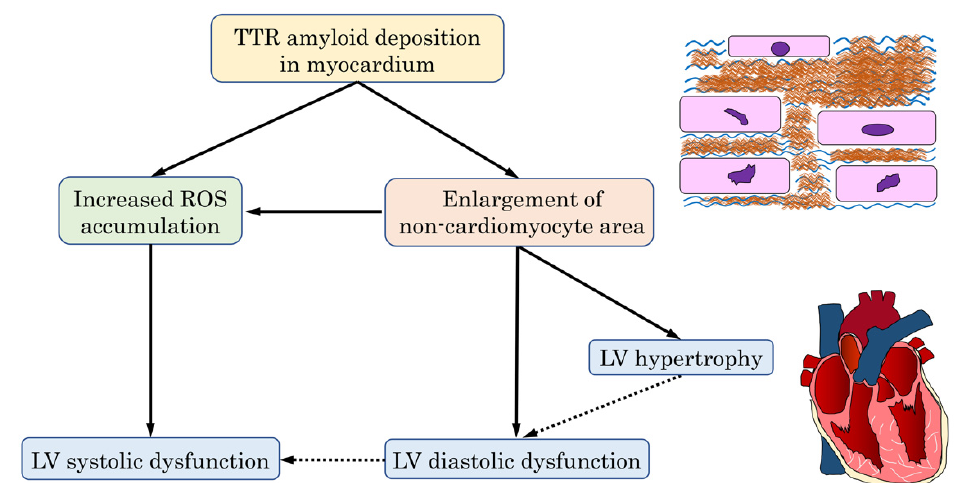
Figure 4. Schematic representation of the mechanism of cardiac dysfunction in ATTR-CM. In hearts displaying ATTR-CM, increased TTR amyloid deposition might be involved in the enlargement of the non-cardiomyocyte area, resulting in LV hypertrophy and LV diastolic dysfunction. Furthermore, the increased TTR amyloid deposition and subsequent enlargement of the non-cardiomyocyte area might lead to increased ROS accumulation, thus causing LV systolic dysfunction. ATTR-CM, transthyretin amyloid cardiomyopathy; LV, left ventricular; ROS, reactive oxygen species; TTR, transthyretin.